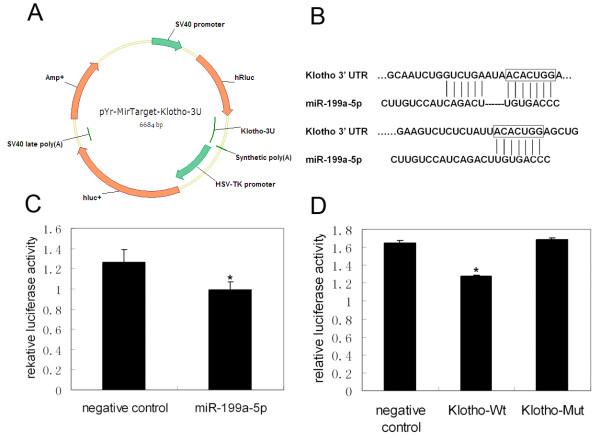
klotho is a direct target of miR-199a-5p. (A) Profile of pYr-MirTarget-Klotho-3′UTR luciferase report plasmid; (B) The positions of the two miR-199a-5p target sites in klotho 3′UTR, showing sequence alignment of miR-199a-5p and the klotho 3′UTR; (C) Luciferase activity was dramatically decreased in the presence of miR-199a-5p mimic when compared with negative control (*P < 0.05). Renilla luciferase activity of each sample was normalized by Firefly luciferase activity. Data were shown as mean ± standard deviation from three independent experiments. (D) HEK293 cells were co-transfected with luciferase reporter plasmid containing either wild type or mutant klotho 3′UTR (indicated as klotho-Wt or klotho-Mut), and the luciferase activity of wild type klotho became much lower than that of mutant type klotho and negative control when miR-199a-5p was introduced (*P < 0.05).